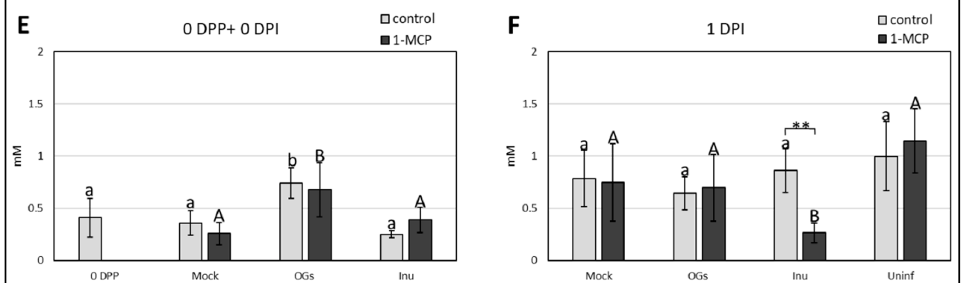
Figure 6. Soluble sugar analysis from leaf samples collected from the 1-MCP experiment. Mock = water-primed leaves; OGs = OGs-primed leaves; Inu = chicory inulin-primed leaves; Uninf = Water-primed leaves inoculated with a mock solution (1/2 strength Potato dextrose broth). ( A ) Suc quantification at 0 DPP (before priming = 0 DPP) and 0 DPI (3 days after priming and before inoculation); ( B ) Suc quantification at 1 DPI; ( C ) Glc quantification at 0 DPP and 0 DPI; ( D ) Glc quantification at 1 DPI; ( E ) Fru quantification at 0 DPP and 0 DPI; ( F ) Fru quantification at 1 DPI. Bars marked with same letter(s) are not significant between each other, bars that have no letters in common indicate significance between treatments ( p < 0.05, one-way ANOVA (analysis of variance) followed by Tukey’s post-hoc test). Lowercase letters refer to comparison between control treatments, capital letters refer to comparison between 1-MCP treatments. Asterisks indicate significance between control and 1-MCP conditions referring to the same priming treatment (* p < 0.05, ** p < 0.01, Student’s t -test). Values represent the average ± standard deviation of five biological replicates.